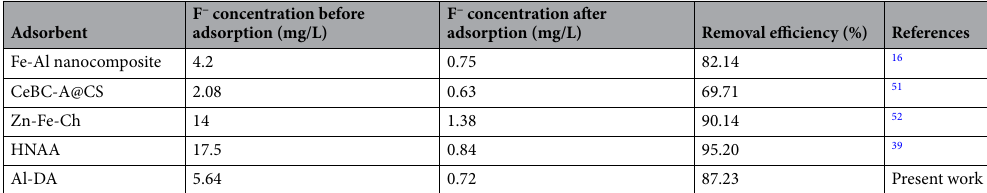
Table 4. Fluoride removal study from the real-life water sample.